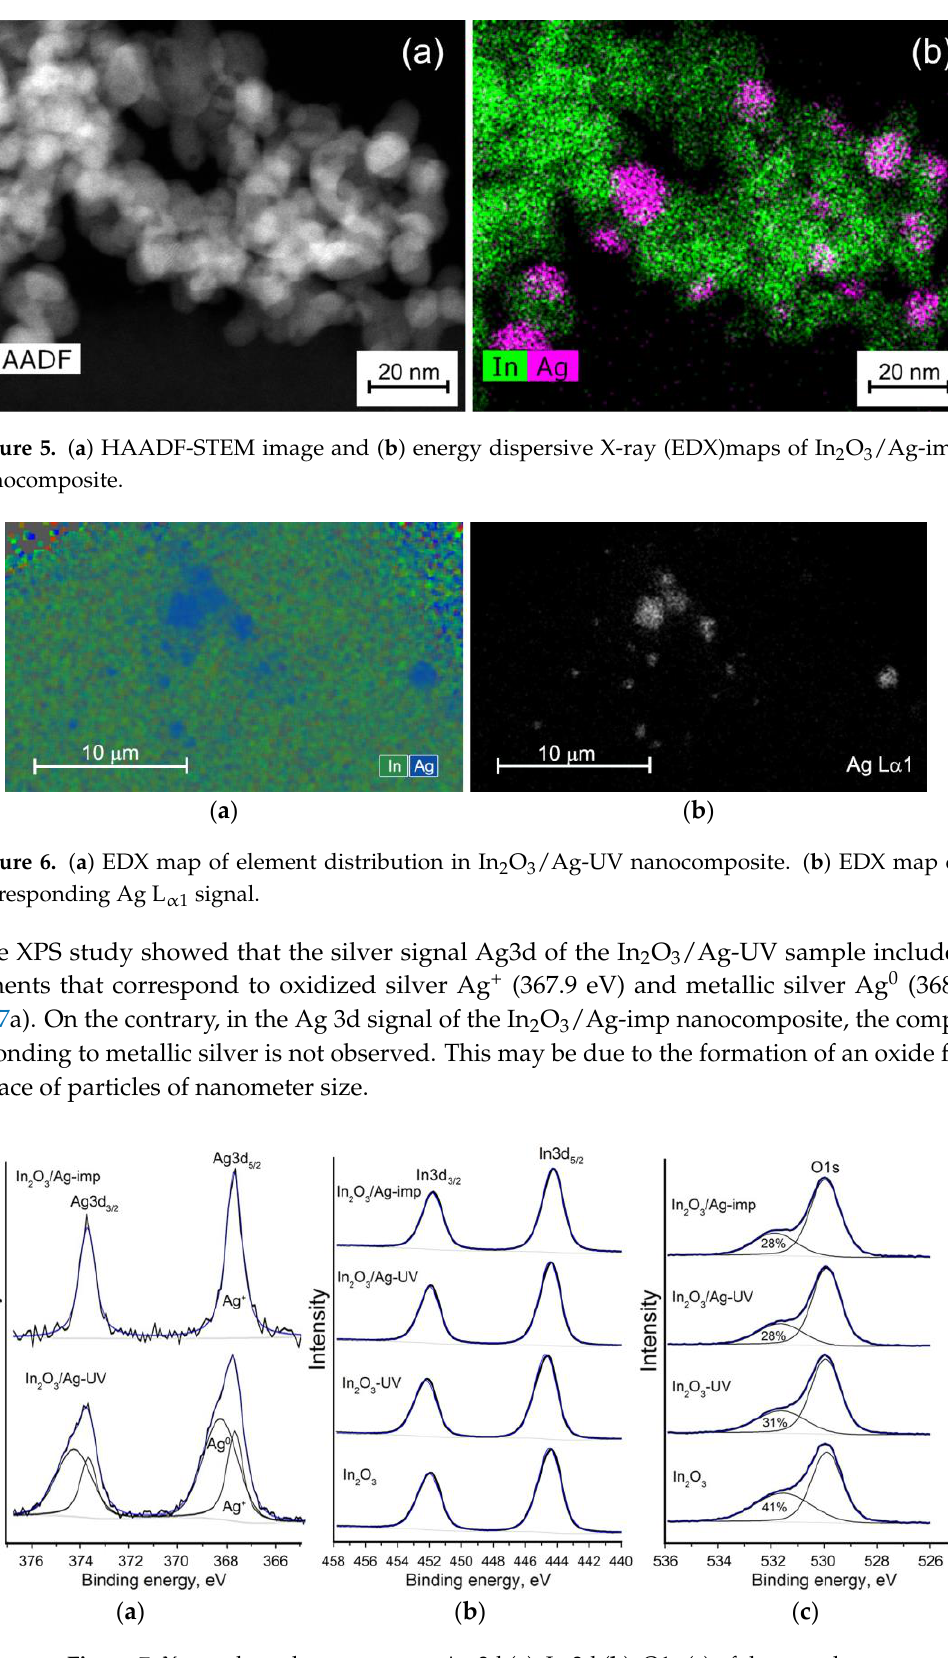
Figure 7. X-ray photoelectron spectra Ag 3d ( a ); In 3d ( b ); O1s ( c ) of the